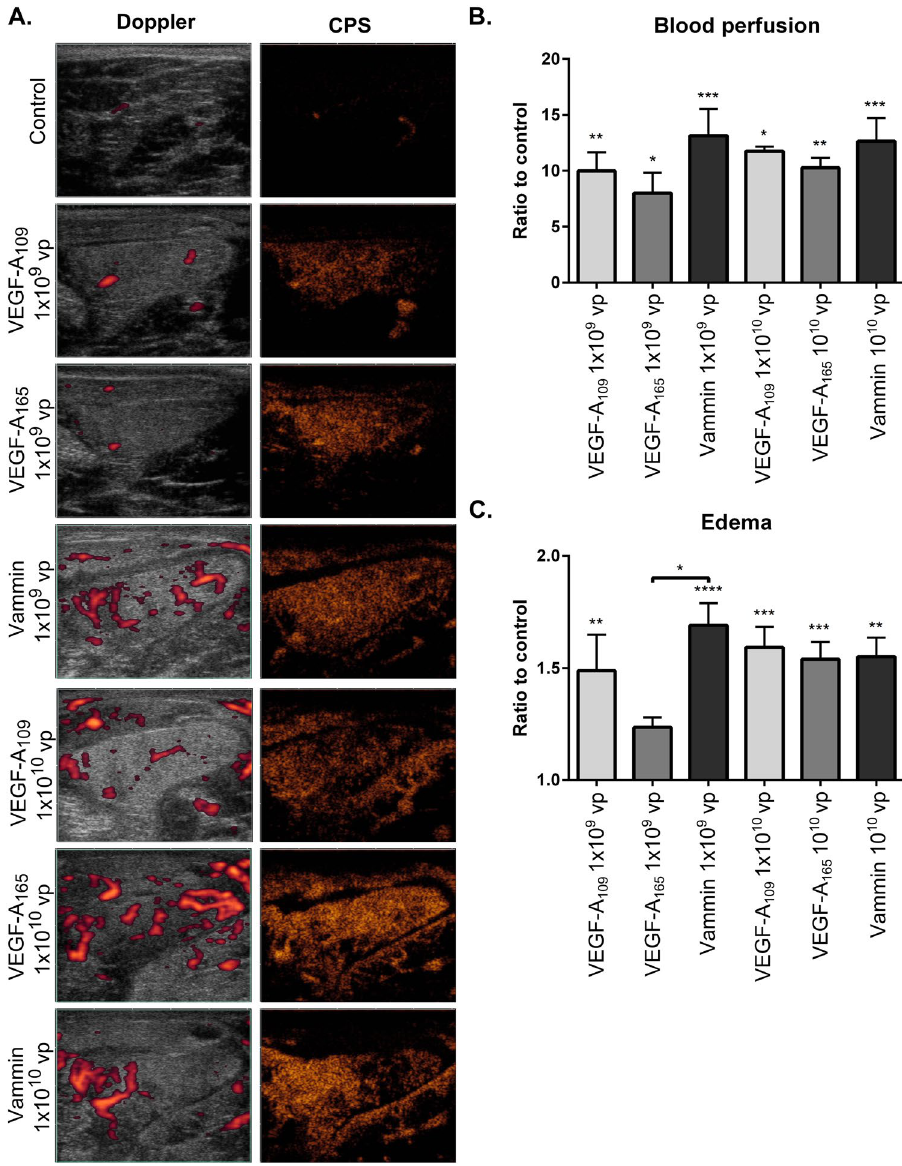
Figure 2. Vammin efficiently induces blood perfusion and edema in skeletal muscles. ( A ) Images with Doppler and CPS ultrasound from the semimembranosus muscles 6 days after the gene transfer. Increased perfusion is seen in all treated muscles. Edema is observed with both doses ( B ) Quantification of the blood perfusion from CPS ultrasound (n = 4–6 per group) ( C ) Quantification of edema from the ultrasound images (n = 4–6 per group). In B to C the data is presented as mean ± SEM. * P < 0.05, ** P < 0.01, *** P < 0.001, **** P <